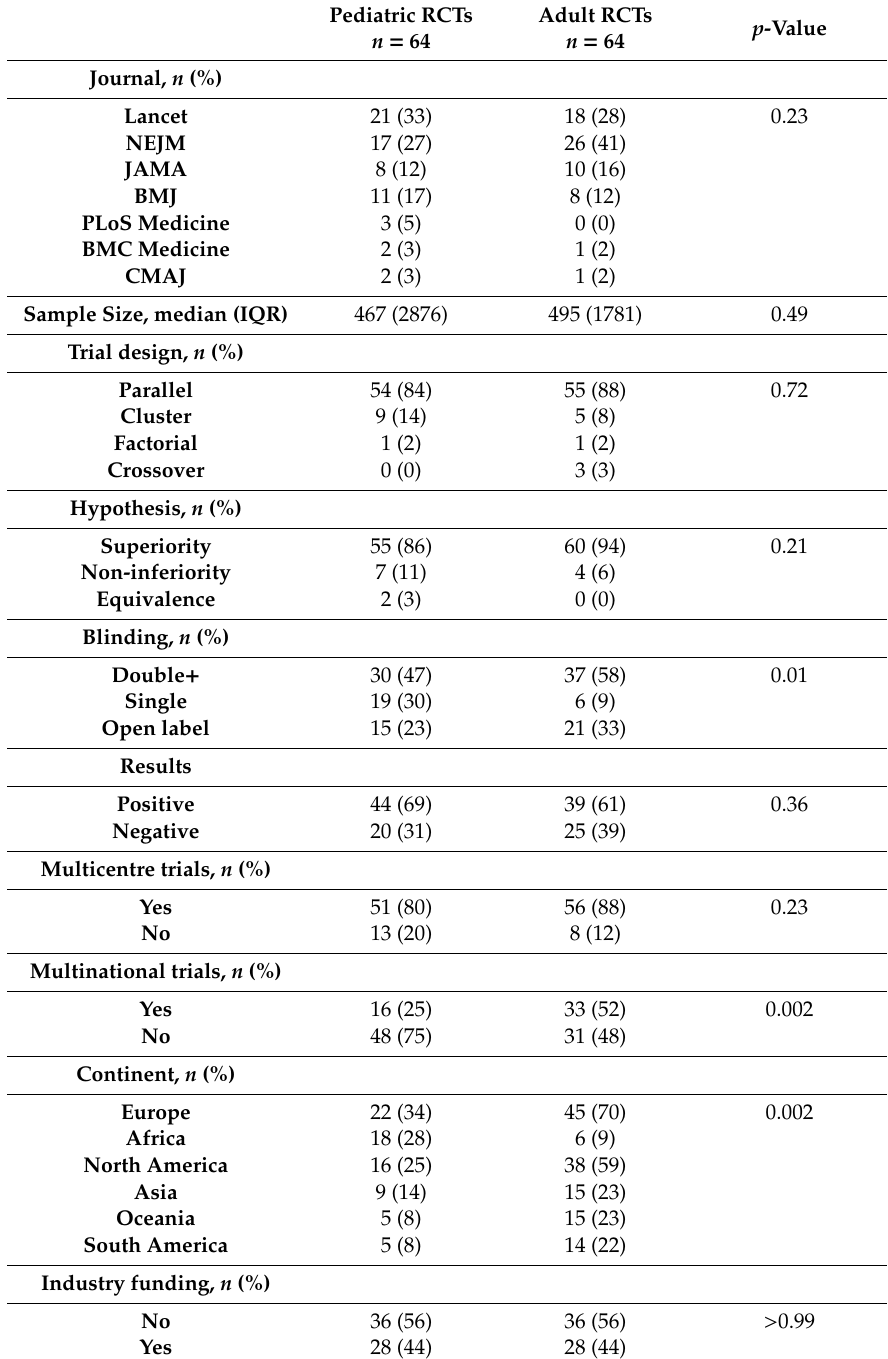
Table 3. Characteristics of a stratified random sample of pediatric and adult RCTs in seven general medical journals,